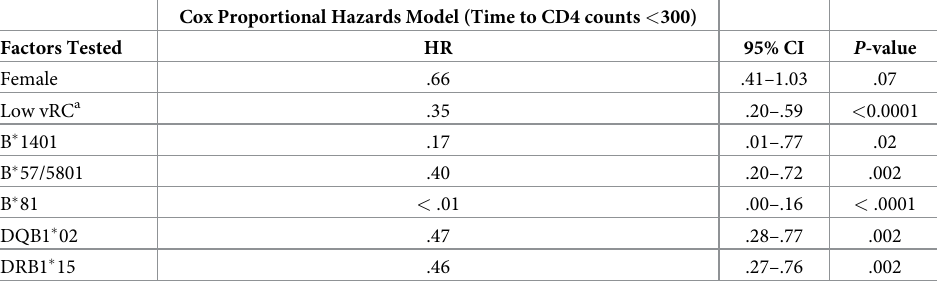
Table 1. HLA alleles associated with significant protection from CD4+ T cell decline. Cox Proportional Hazards Model (Time to CD4 counts <